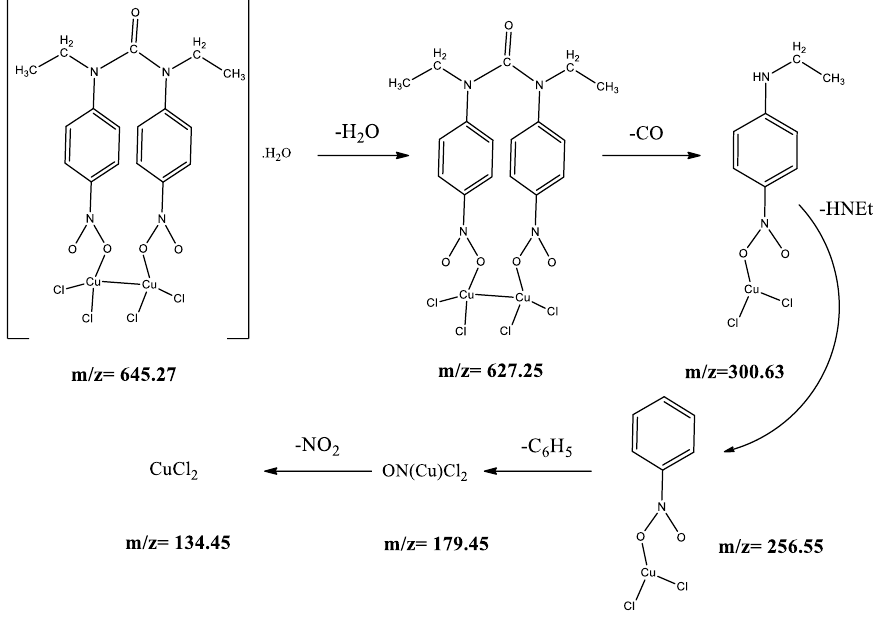
Figure 5. Mass fragmentation pattern of the CuL complex.